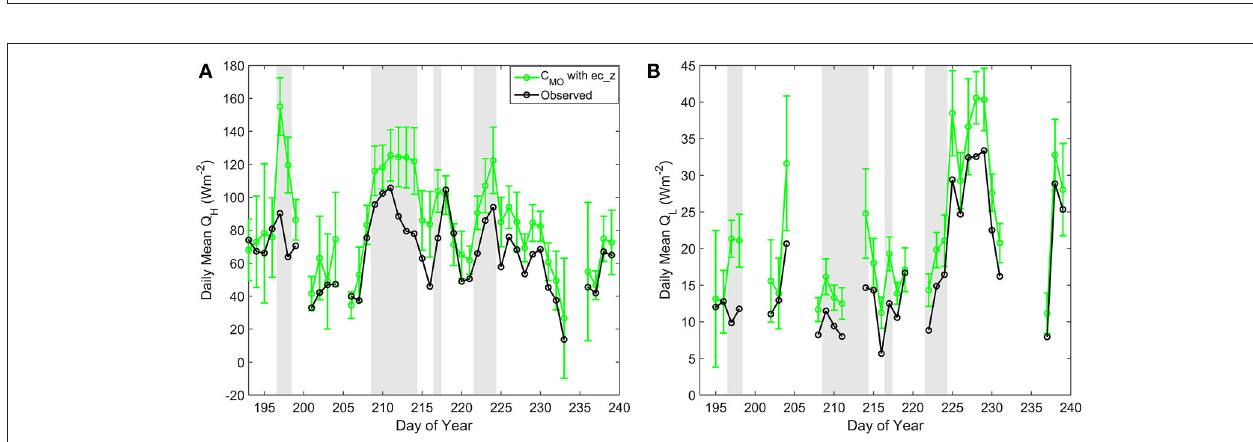
FIGURE 10 | Daily means of observed turbulent heat fluxes (black) and C MO modeled fluxes using ec _ z roughness lengths (green), for (A) Q H , and (B) Q L . Periods with suspected low-level katabatic wind maximums are shaded gray. Daily means only include the 30 min periods which pass the filters for ideal EC measurement conditions. Error bars on the modeled fluxes represent the standard deviation of the daily means from the Monte Carlo sensitivity